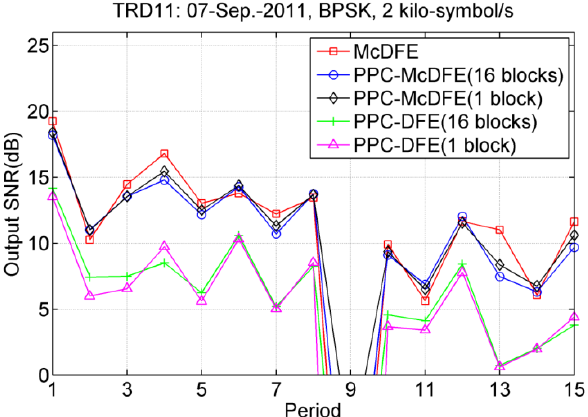
16. Performance comparison between the one block approach and the multi-block